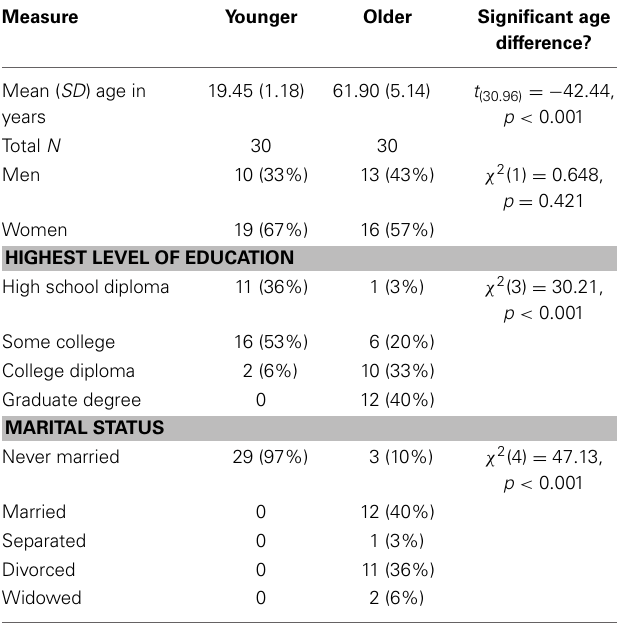
Table 1 | Characteristics of the